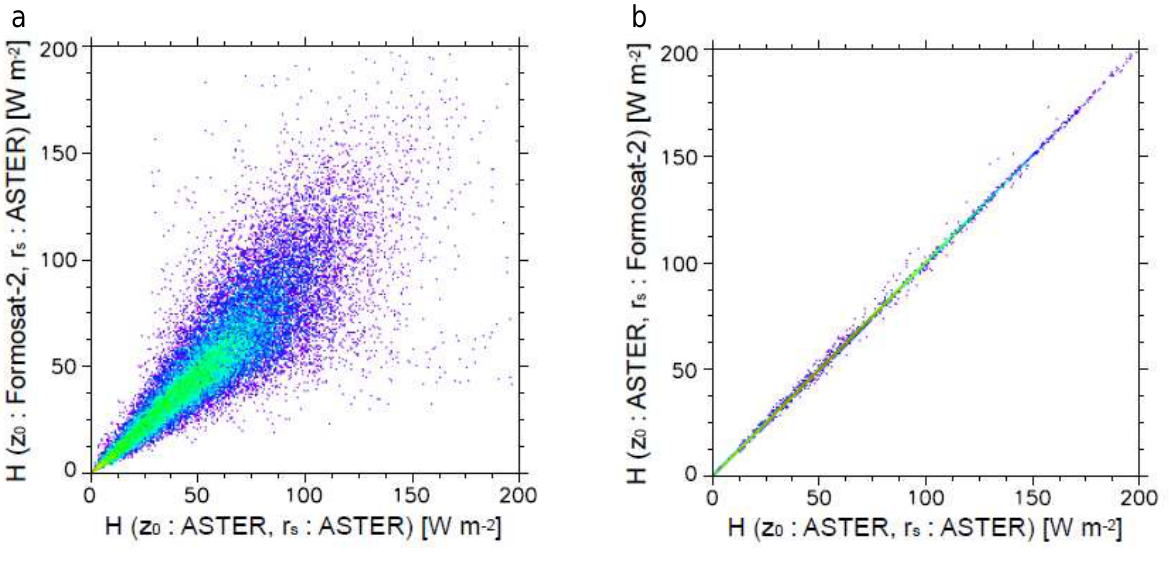
Figure 7. Scatterplots of sensible heat flux, H , estimated from ASTER vs. a) sensible heat flux estimated based on the roughness length from Formosat-2 and the minimum stomatal resistance from ASTER, and b) sensible heat flux estimated based on the roughness length from ASTER and the minimum stomatal resistance from